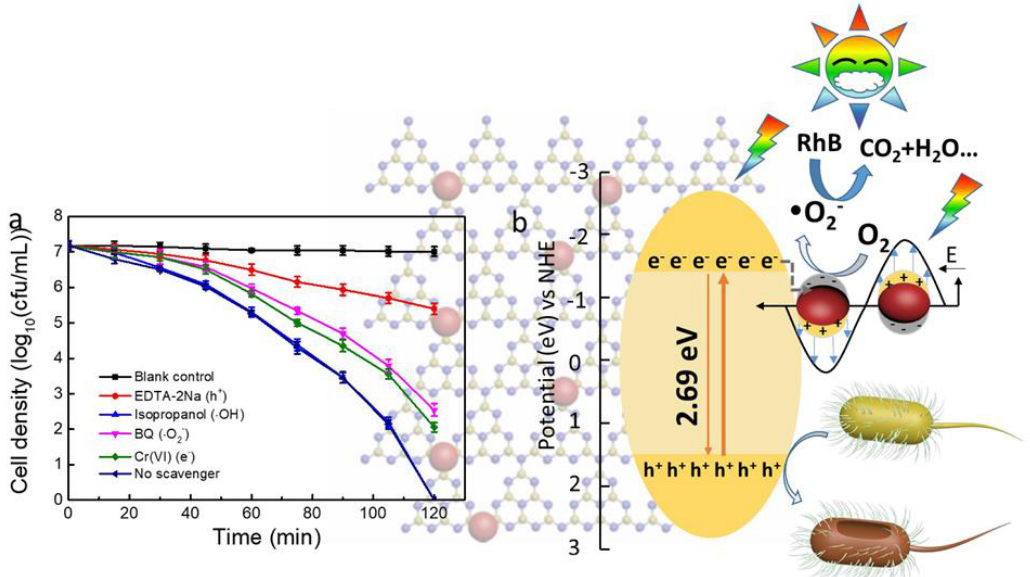
Figure 4. ( a ) Effect of the Ag/g-C 3 N 4 composite on the cell density and ( b ) graphical depiction of the Figure 4. ( a ) E ff ect of the Ag / g-C 3 N 4 composite on the cell density and ( b ) graphical depiction of possible antimicrobial mechanisms and organic pollutant removal using a Ag/g-C 3 N 4 composite. the possible antimicrobial mechanisms and organic pollutant removal using a Ag / g-C 3 N 4 composite. Adapted from Wei et al. [43] . Adapted from Wei et al.